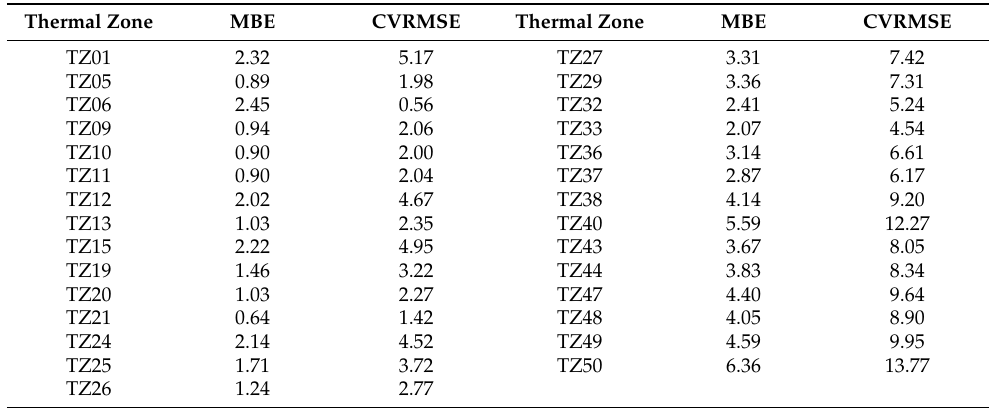
Table A2. Absolute value of Mean Bias Error (MBE) and the Coefficient of Variation of the Root Mean Square Error (CV(RMSE)) for each building thermal